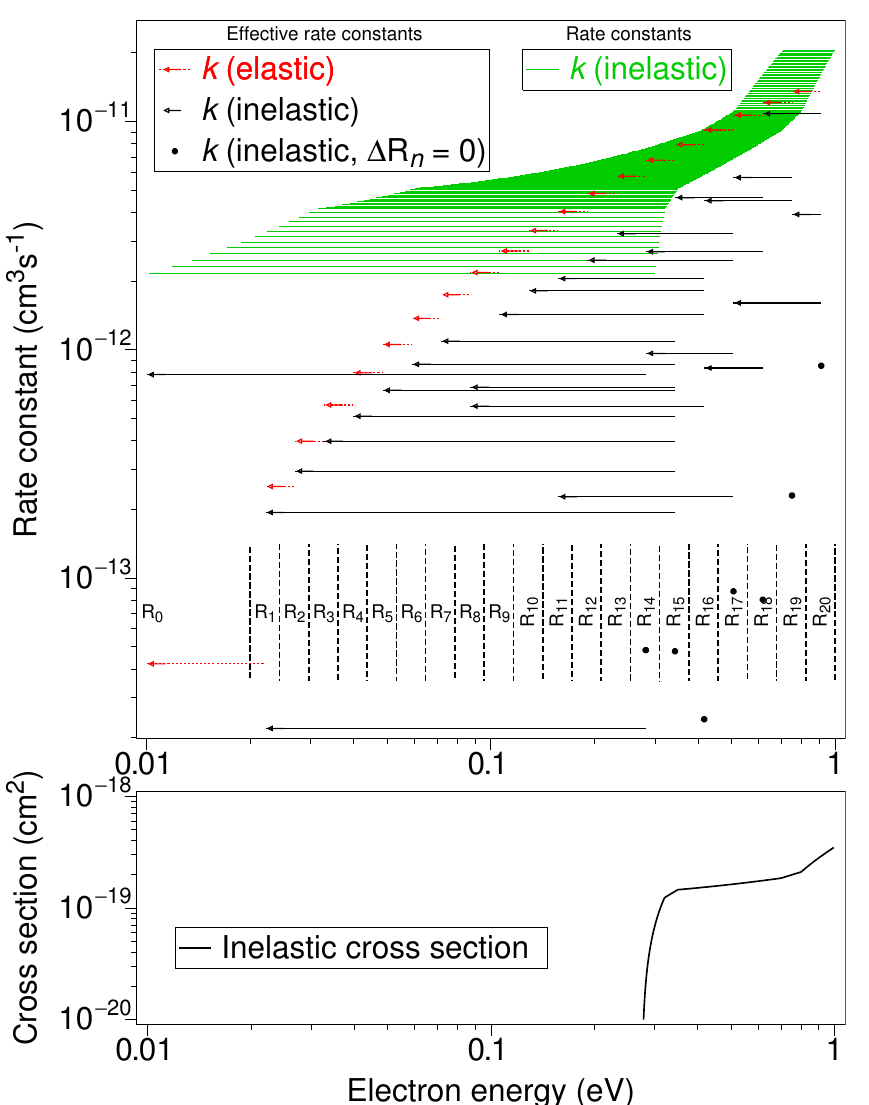
Figure 6. ( Lower panel) Cross-section (cm 2 ) as a function of electron energy (eV) for electron-impact excitation of the first vibrational level in N 2 . ( upper panel) Rate constants (cm 3 s − 1 ) as a function of electron energy (eV) derived from the cross-sections, represented by horizontal lines drawn from the initial energy of the electron to its final energy. Averaged rate constants for all transitions from one energy subrange to another, for vibrational excitation (arrows with solid lines) and elastic collisions (arrows with dotted